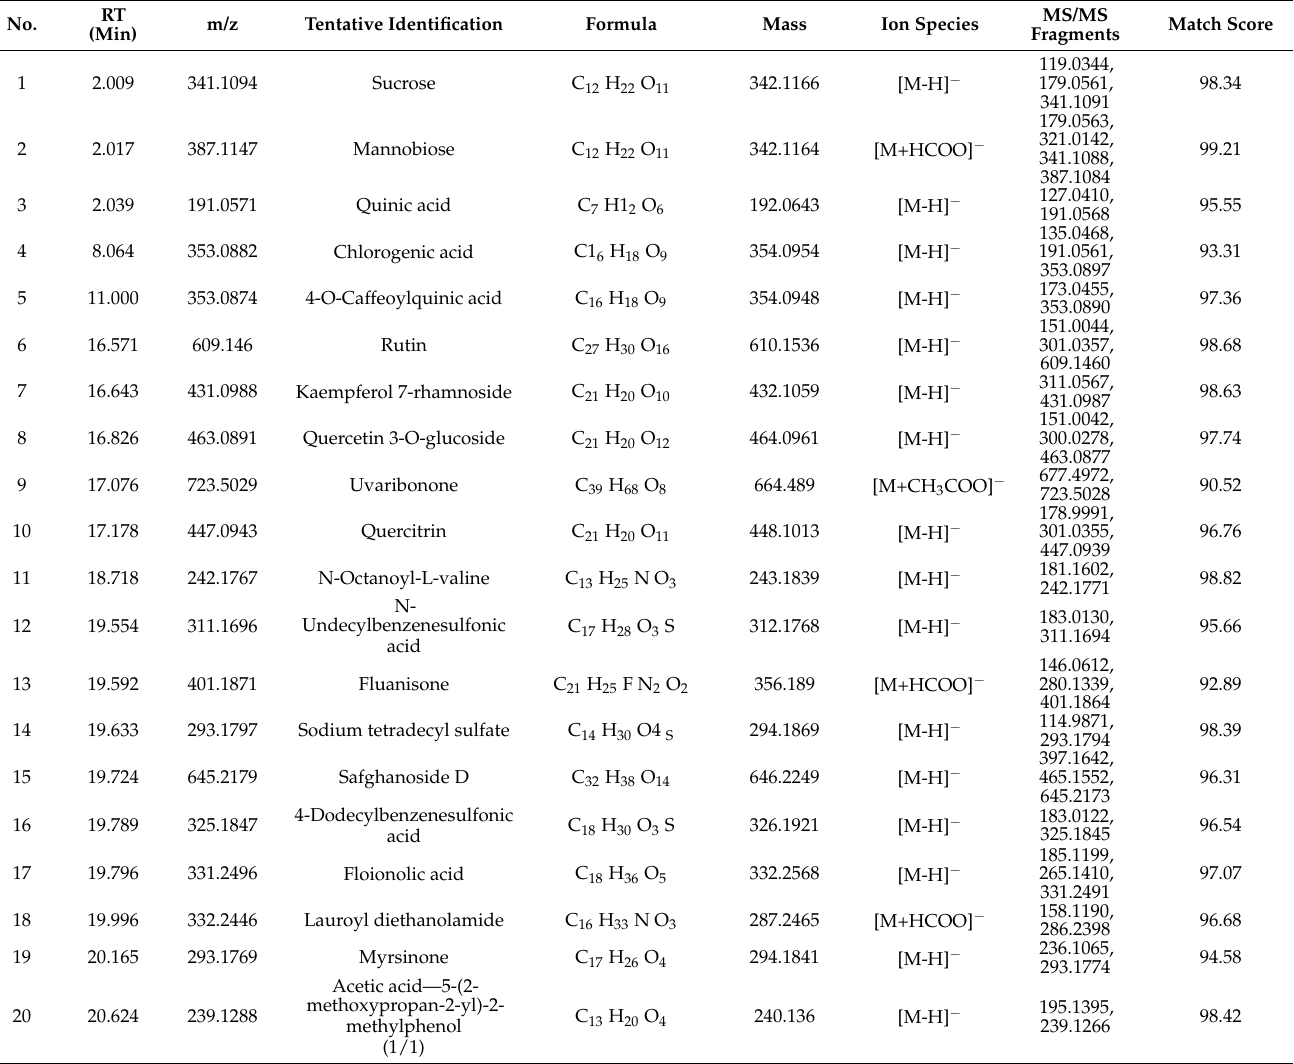
Table 4. Phytochemicals identified in HCE by LC-QTOF-MS-MS data in the negative ion